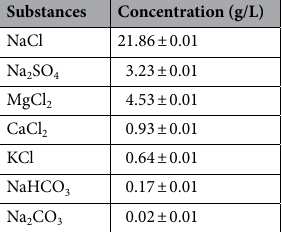
Table 1. Artificial seawater formulation.